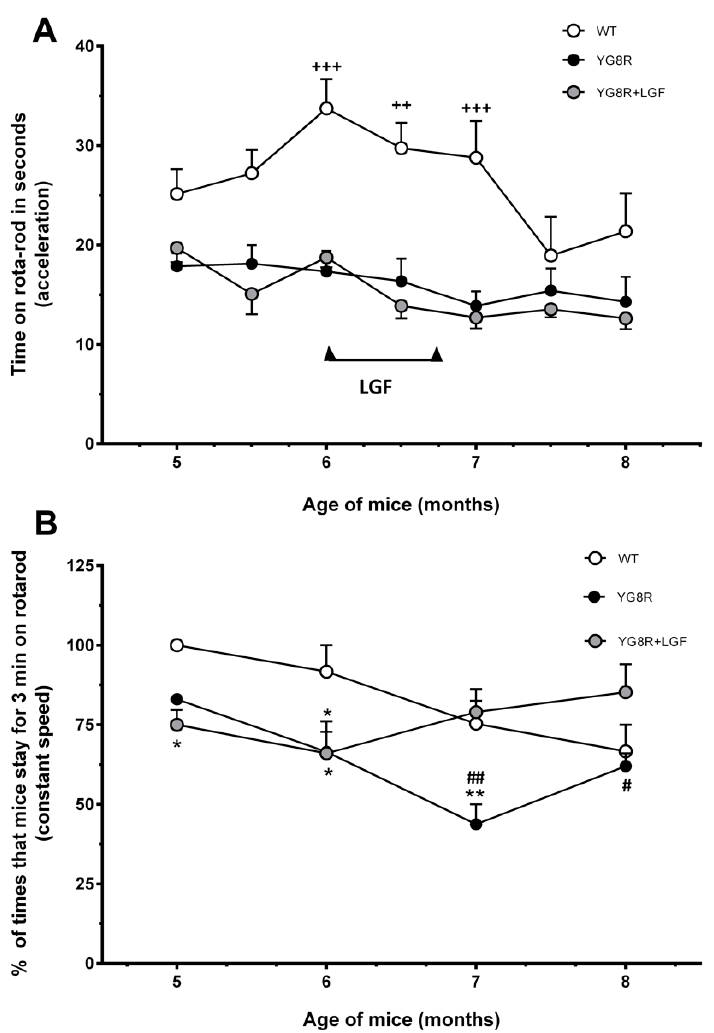
Figure 1. Liver growth factor (LGF) treatment partially restores motor coordination in YG8R mice. ( A ) Shows the time (in seconds) spent on the rotating rod at increasing acceleration of the three groups of animals observed, demonstrating that under this demanding rotarod condition no beneficial effect of LGF is detected; In ( B ) the % of times that mice stay on the rotating rod for 3 min at constant speed (4 rpm) in the WT ( white circles), YG8R ( black circles), or YG8R+LGF ( grey circles) mice. Note the poorer performance of YG8R versus WT mice of five to seven months, and that shortly after treatment values are significantly higher in the LGF-treated than in the vehicle-treated YG8R mice. Results are the mean ± Standard Error of Mean (SEM) of 6–8 independent animals. ++ p < 0.01, +++ p < 0.001 vs. YG8R; * p < 0.05, ** p < 0.01 vs. WT; # p < 0.05, ## p < 0.01 vs.